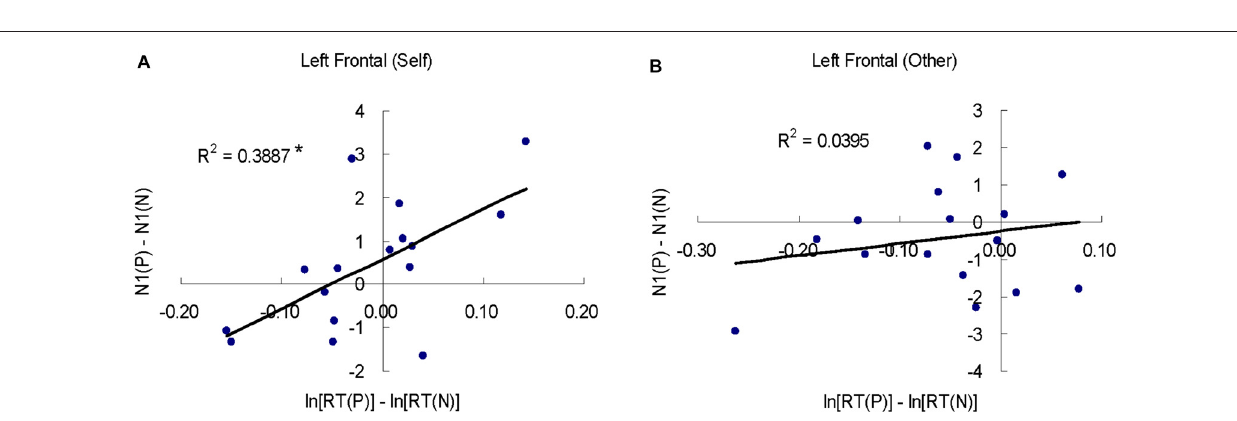
Frontiers in Human Neuroscience |